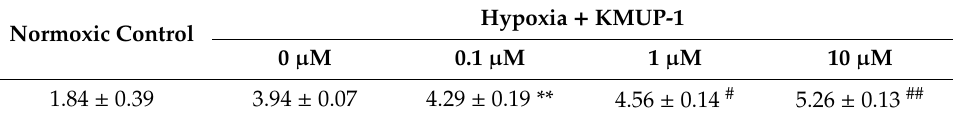
Table 1. Effect of KMUP-1 on plasma nitric oxide concentration ( μ M) . Table 1. E ff ect of KMUP-1 on plasma nitric oxide concentration ( µ M).